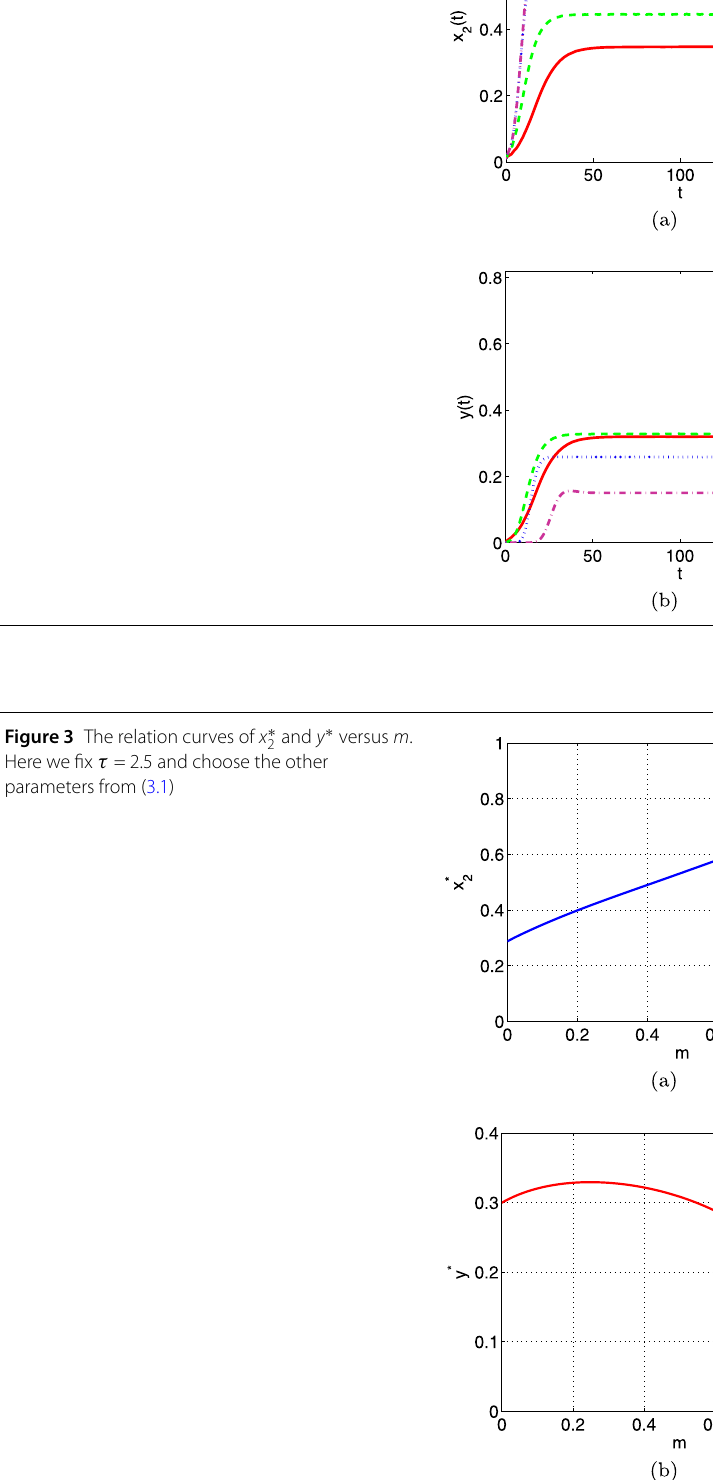
Figure 2 All solutions converge to the interior equilibrium E ∗ for different m . Here we fix τ = 2.5 and choose the other parameters from (3.1) with the initial condition ( x 2 (0), y (0)) = (0.01,0.001)